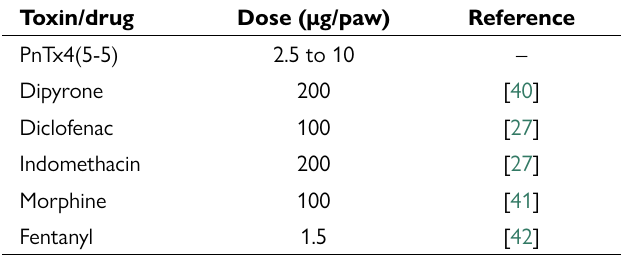
Table 1. Comparative table of doses of substances that induce antinociceptive effect when administered in rat paw Toxin/drug Dose (µg/paw)